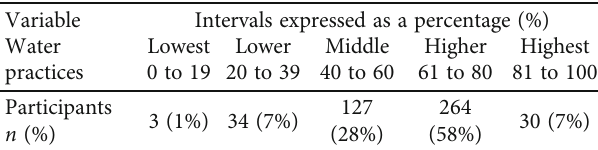
Table 5: Water practice scores among study participants.